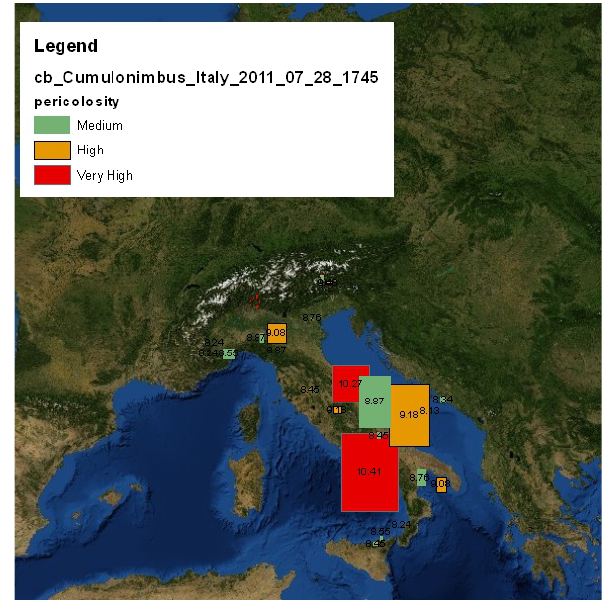
Figure 6. Rectangles representing convective clouds (and their corresponding hazard levels and heights) occurring 28 July 2011, 17:45UTC.